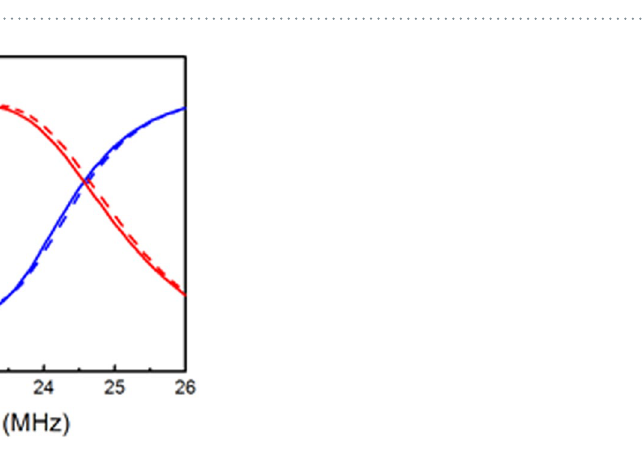
Figure 4. Time-domain current waveforms at resonant frequency. ( a ) Waveforms when the terminal load is an inductor of 68.6 nH. ( b ) Waveforms when the terminal load is a capacitor of 686 pF. ( c ) Waveforms when the terminal load is a resistor of 10 Ω. Red lines represent current I 1 , and blue lines represent current I 2 .